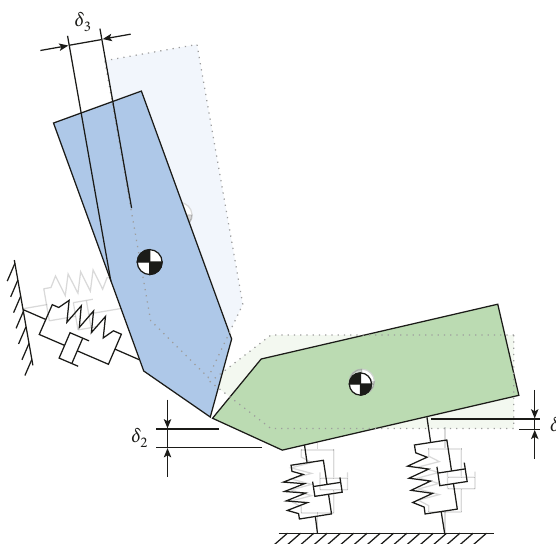
Figure 1: The proposed five-degree-of-freedom seated biodynamic human mathematical model (red colored symbols: generalized